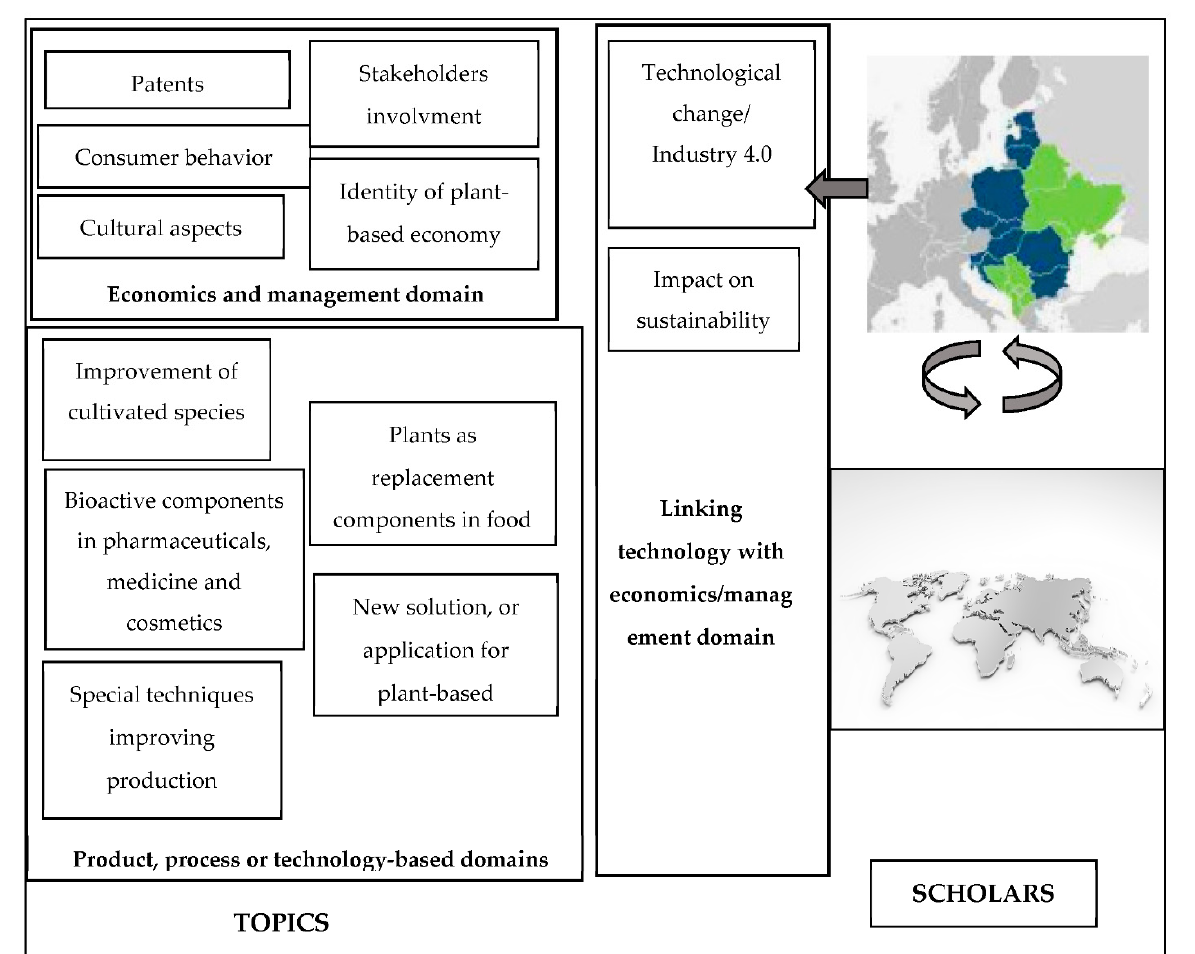
Figure 1. Framework for future research. The left arrow: research conducted in different countries is needed. The ringed arrows: cooperation between academics from different countries is needed